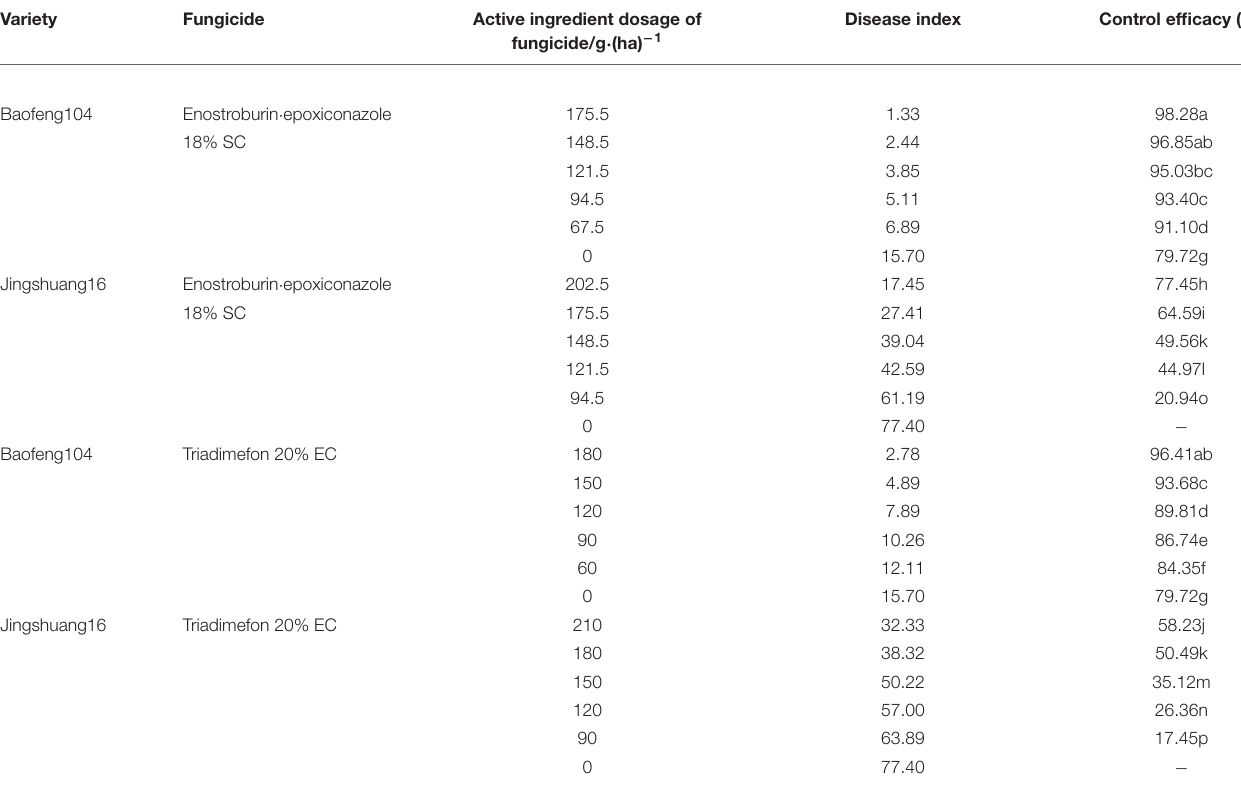
Different letters indicate significant differences at the 0.05 level by Duncan’s multiple comparisons.